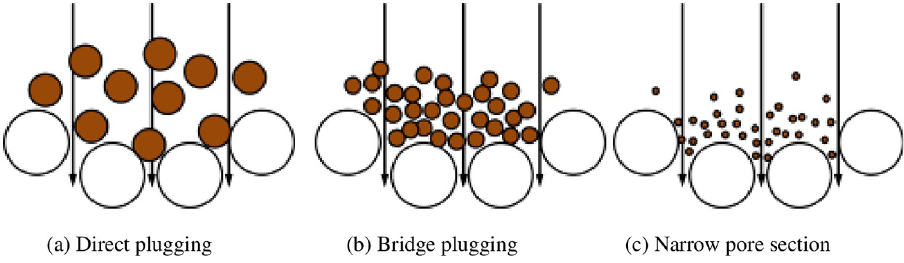
Fig 12. Schematic diagrams of particle migration and deposition. (a) Direct plugging. (b) Bridge plugging. (c) Narrow pore